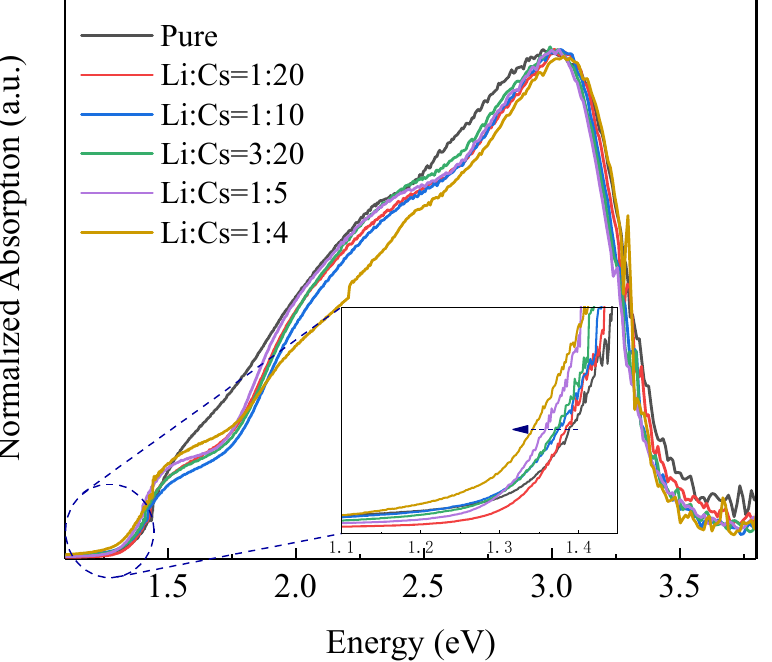
Figure 9. Normalized absorption spectrums of undoped Cs 2 SnI 6 and Li + doped Cs 2 SnI 6 with different concentrations. The inset is the partial enlarged normalized absorption spectra from 1.1 to 1.5 eV.